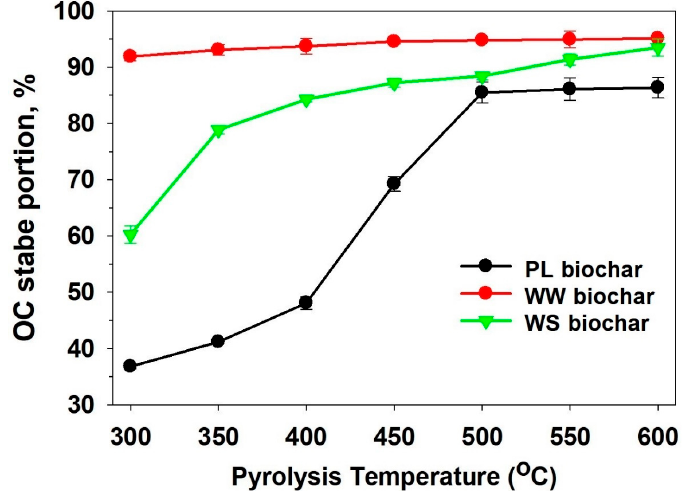
Figure 1. The stable proportion of organic carbon (OC) in biochars derived from waste wood (WW), wheat straw (WS), and poultry litter (PL) through complete slow pyrolysis at 300–600 °C peak temperatures. Error bars represent standard deviation of triplicate measurements. The stable OC content was measured in <0.15 mm sample replicates using the dichromate oxidation methods [10].